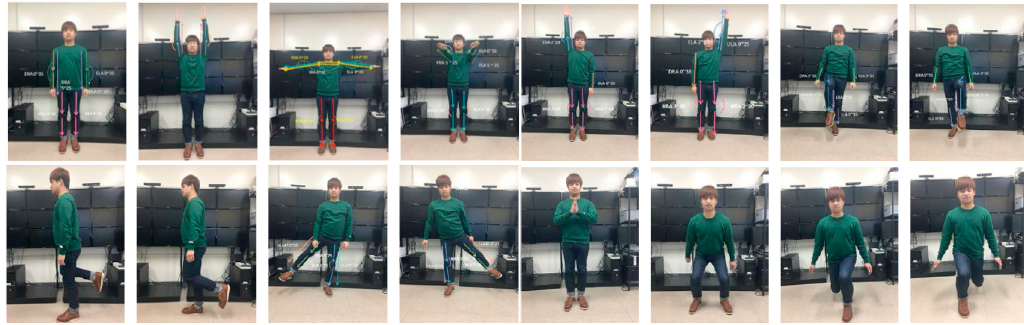
Figure 6. The 16 exercise postures: BSD, BSU, BSO, BSF, RHU, LHU, RKU, LKU, RKC, LKC, RLAB, LLAB, BHC, SQUAT, RLUNGE, LLUNGE (from top left to bottom right). The proper exercise form, Pi, is represented as Equation (5), using the angles representing the body, left/right arm, left/right leg and the distance between both hands and feet. A description of each feature is given in Table 1. These angle and length features are used to analyze and distinguish between the different exercise body postures. For example, SSA is the angle of the spine when it is upright and is the angle between SS (Spine Shoulder), SB (Spine Base), and up vectors. ELA (Elbow